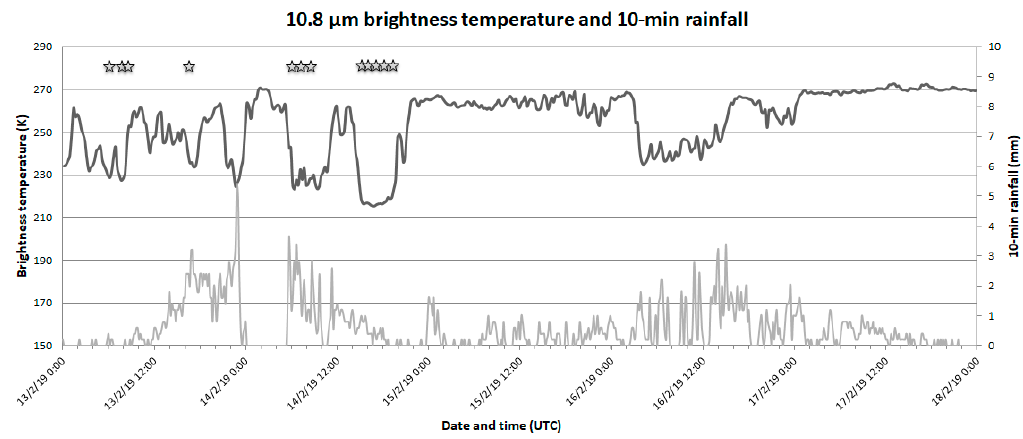
Figure 12. Time evolution of 10.8 µ m brightness temperature (at 15-min intervals) and of 10-min accumulated rainfall at Askyfou area, during the 5-day period, starting at 0000 UTC 13 February 2019. Stars at the top of the diagram indicate the time periods of convective activity.